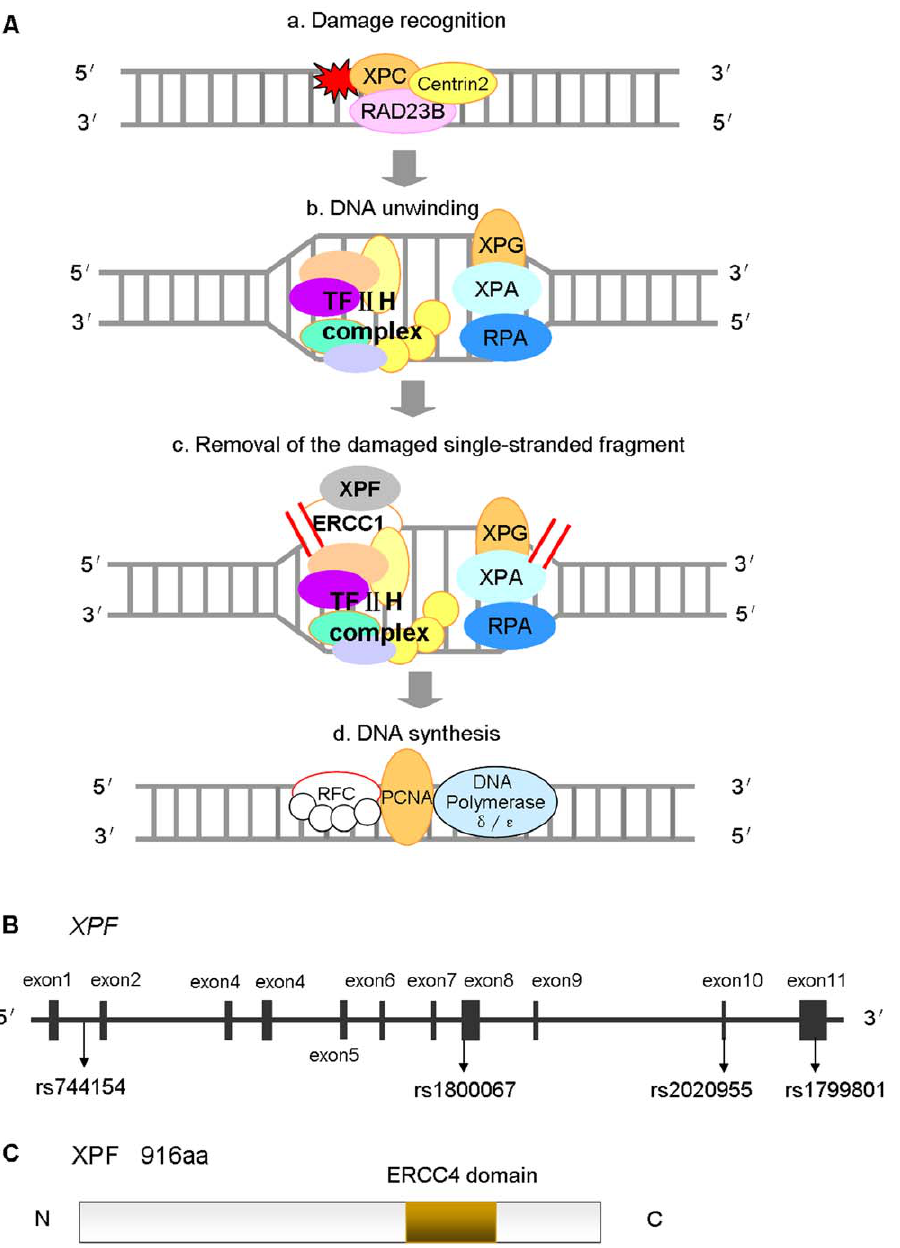
Figure 1. Structural characteristics and function of XPF as modified from KEGG and GeneBank database. (A) NER involves at least four steps: (a) damage recognition by a complex of bound proteins including XPC, (b) unwinding of the DNA by the TFIIH complex that includes XPD, (c) removal of the damaged single-stranded fragment by molecules including an ERCC1/XPF complex, and (d) synthesis by DNA polymerases; (B) The XPF gene map labeled with 11 exons, and four polymorphisms that have been commonly studied for their associations with cancer risk